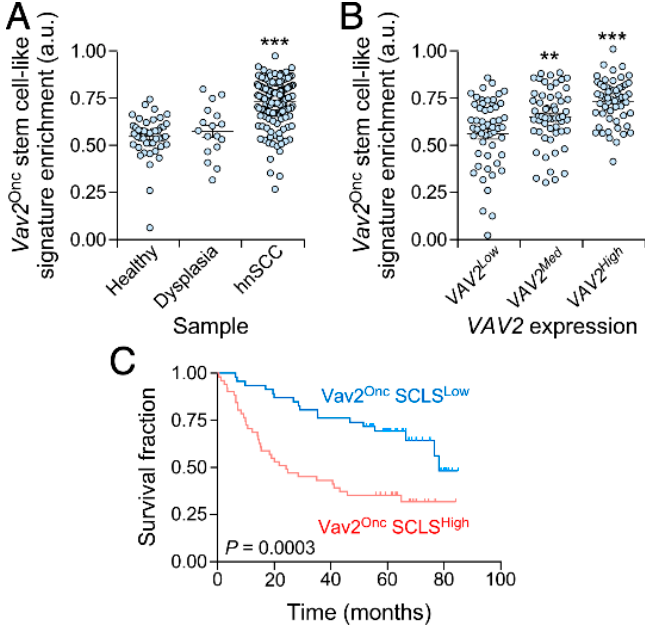
Figure 5. The Vav2 Onc -induced stemness signature has prognostic value in head and neck squamous cell carcinoma patients. ( A ) Dot plot showing the enrichment of the Vav2 Onc SCL signature in the indicated samples from the GSE30784 dataset. ***, p < 0.001 (ANOVA and Tukey’s HSD test). hnSCC, head and neck squamous cell carcinoma. ( B ) Dot plot showing the enrichment of the Vav2 Onc SCL signature according to VAV2 expression levels in tumor samples from the GSE30784 dataset. **, p < 0.01; ***, p < 0.001 (ANOVA and Tukey’s HSD test). ( C ) Kaplan-Meier survival plots of hnSCC patients from GSE41613 dataset according to the enrichment of the Vav2 Onc SCL signature. The Mantel–Cox test p value is indicated.